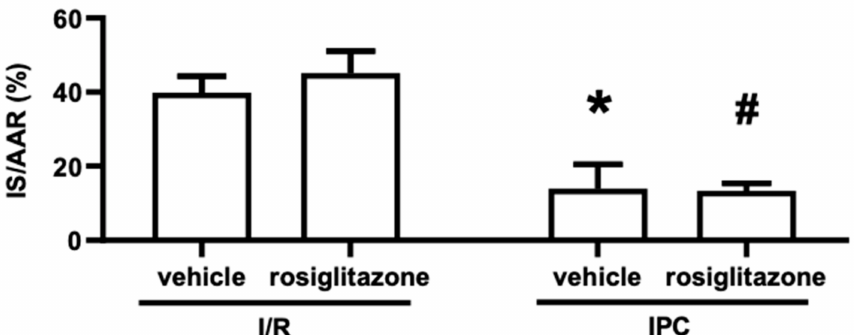
Figure 1. In vivo experimental protocol of myocardial ischemia/reperfusion injury and ischemic preconditioning in rats. Ischemia was implemented by occlusion of the left anterior descending coronary artery, and an electrocardiogram, body temperature, heart rate (Supplementary Table S2), and blood pressure (Supplementary Table S3) were recorded during the protocol. IPC : ischemic preconditioning; I/R : ischemia/reperfusion; P.O. : per os.